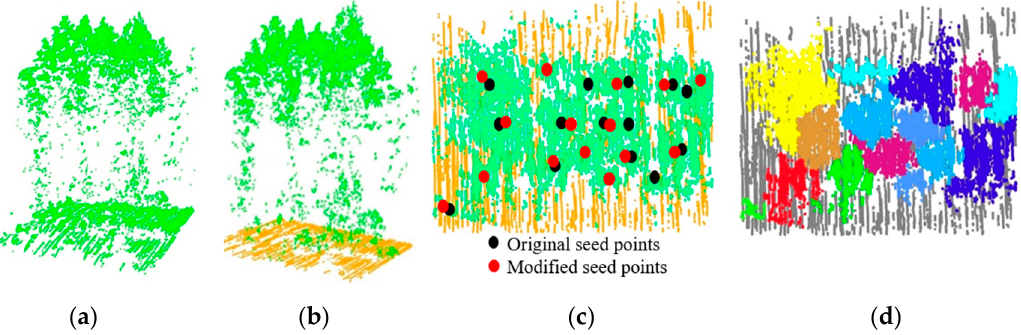
Figure 6. ( a ) Raw data of lidar point cloud; ( b ) normalization based on classified ground points; ( c ) generation of seed points by layer stacking (black points) and modification of seed points by artificial (red points); ( d ) illustration of single tree segmentation with seed points.